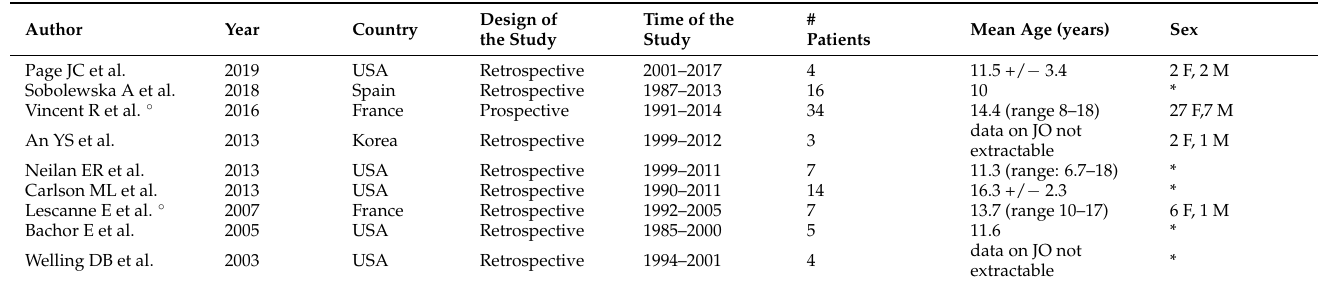
Table 2. Demographics. Legend: ◦ = studies focused only on JO; * = not possible to extract this specific data on JO patients; F = female, M = male.